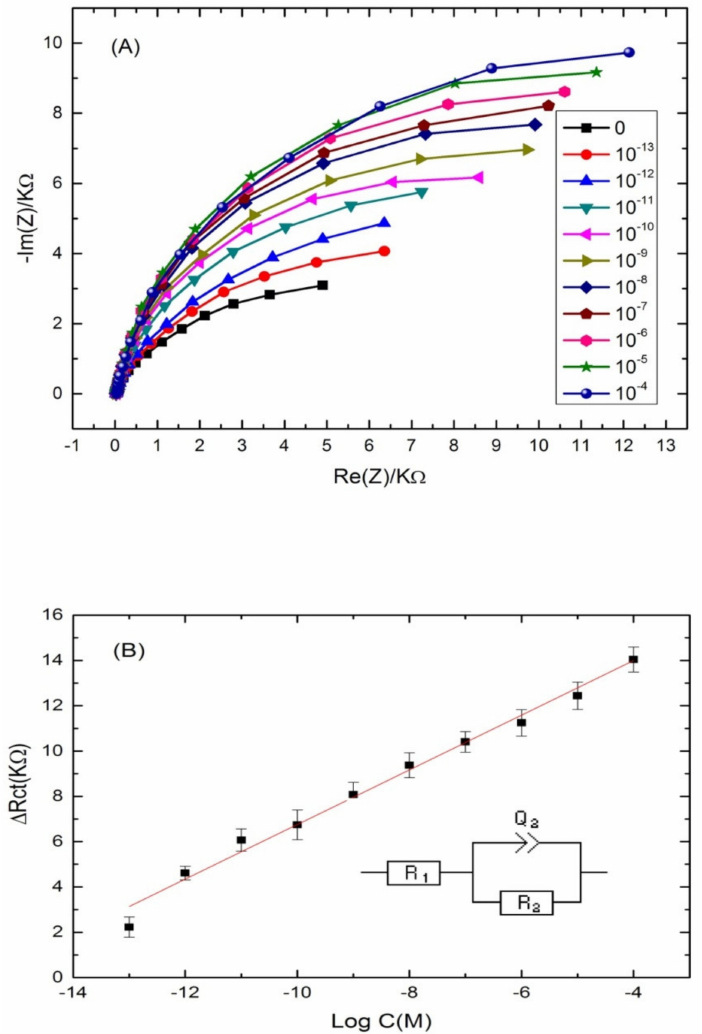
Figure 4. ( A ) Nyquist plots of Cd-aptamer-modified surface incubated with increasing concentrations of cadmium ranging from 10 − 4 to 10 − 13 M. Measurements were performed in buffer (pH 4.5) at a potential of − 0.5 V and a frequency range from 10 kHz to 100 mHz. ( B ) Calibration plots of the increase of the charge transfer resistance with cadmium concentration for the label free aptasensor. Inset: equivalent circuit used for the EIS equivalent circuit